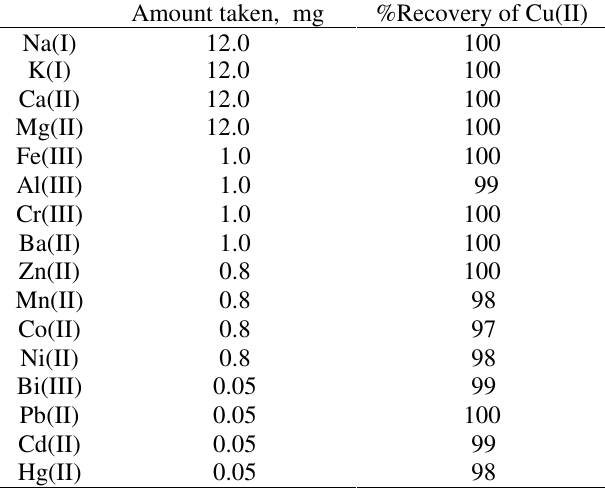
Table 2 . Effect of foreign ions a .